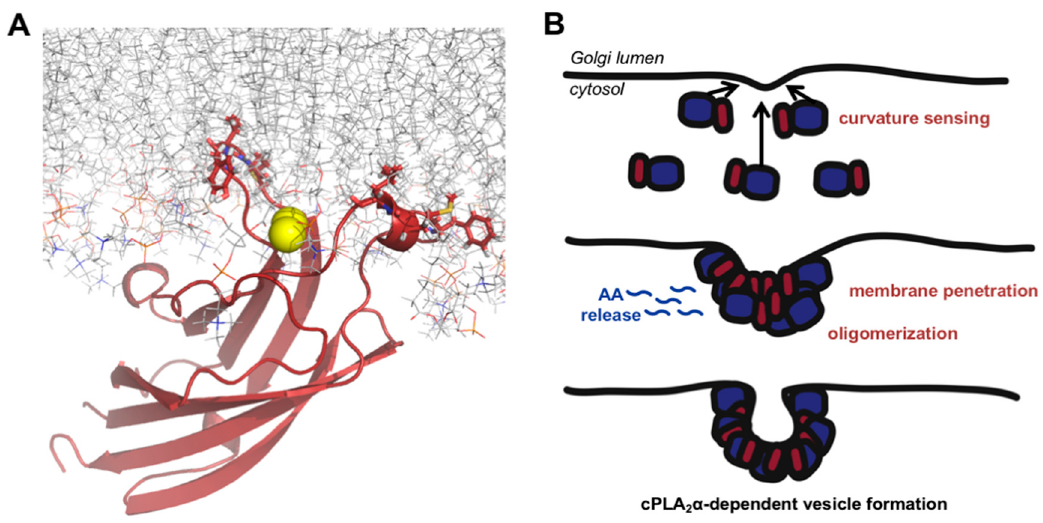
Figure 9. Mechanistic hypothesis of cPLA 2 α induced membrane curvature changes, curvature sensing and vesicle formation. ( A ) cPLA 2 α -C2 (PDB 1CJY) shown penetrating into a POPC bilayer. The structure of the C2 domain is displayed as a ribbon in red, the hydrophobic penetrating residues are shown as red sticks and the POPC molecules are shown as lines. The sticks and lines are colored so that the hydrogen atoms are light grey, nitrogen atoms are blue, and oxygen atoms are light red. ( B ) A schematic of the current model for the generation of cPLA 2 α -induced membrane curvature with contributions from membrane penetration, protein oligomerization and lipid metabolism of acyl chains at the sn-2 positions to produce arachidonic acid (AA) and lysophospholipid. Panel A was generated with Pymol while panel B was drawn using Adobe Illustrator.